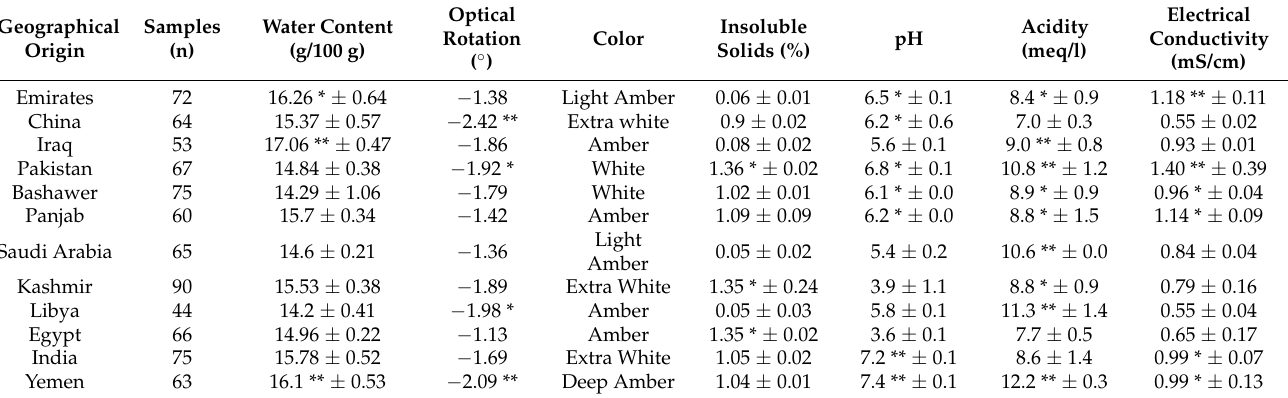
Figure 1. Pollen grain images from microscope preparations of Sidr honey from different geographical origins. Table 3. Physicochemical parameters of Sidr honey samples from different